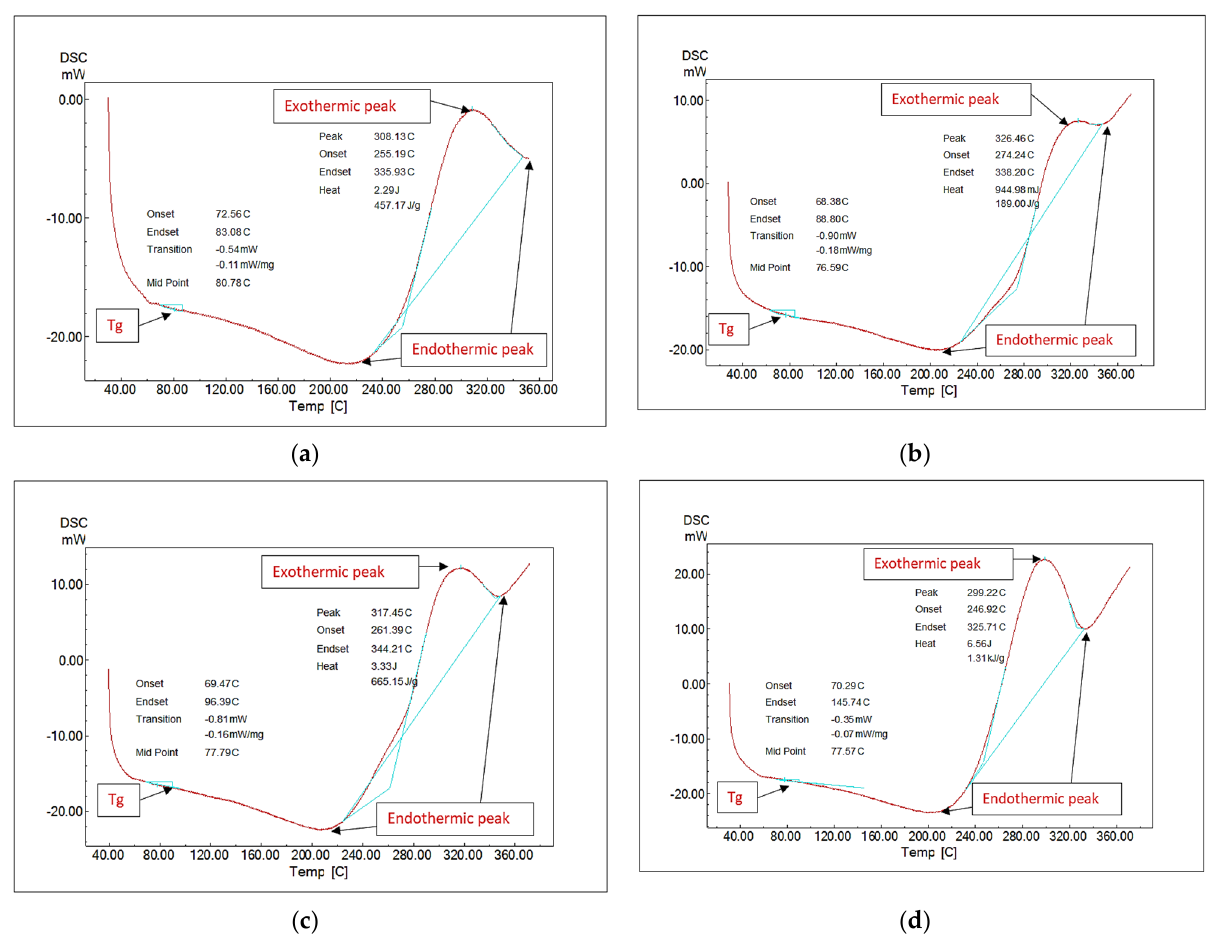
Figure 2. Differential scanning calorimetry (DSC) analysis: ( a ) neat epoxy, ( b ) 15% nanosilica, ( c ) 15% nanoglass, and ( d ) 15% nano–fly ash.